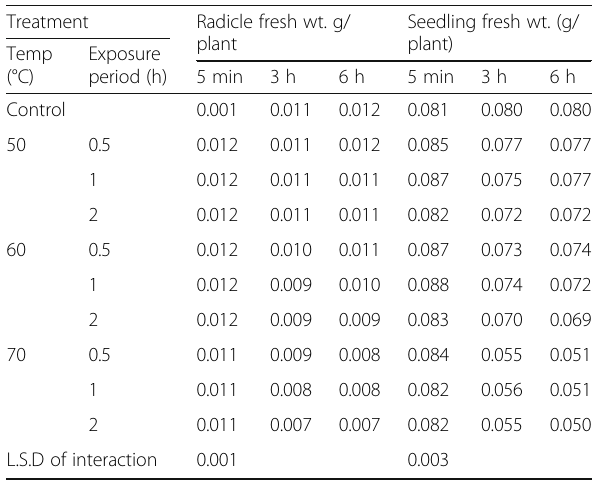
Table 3 Effect of seed hardening on radicle fresh weight (g/ plant) and seedling fresh weight (g/plant) Treatment Radicle fresh wt. g/ Seedling fresh wt. (g/ plant plant)